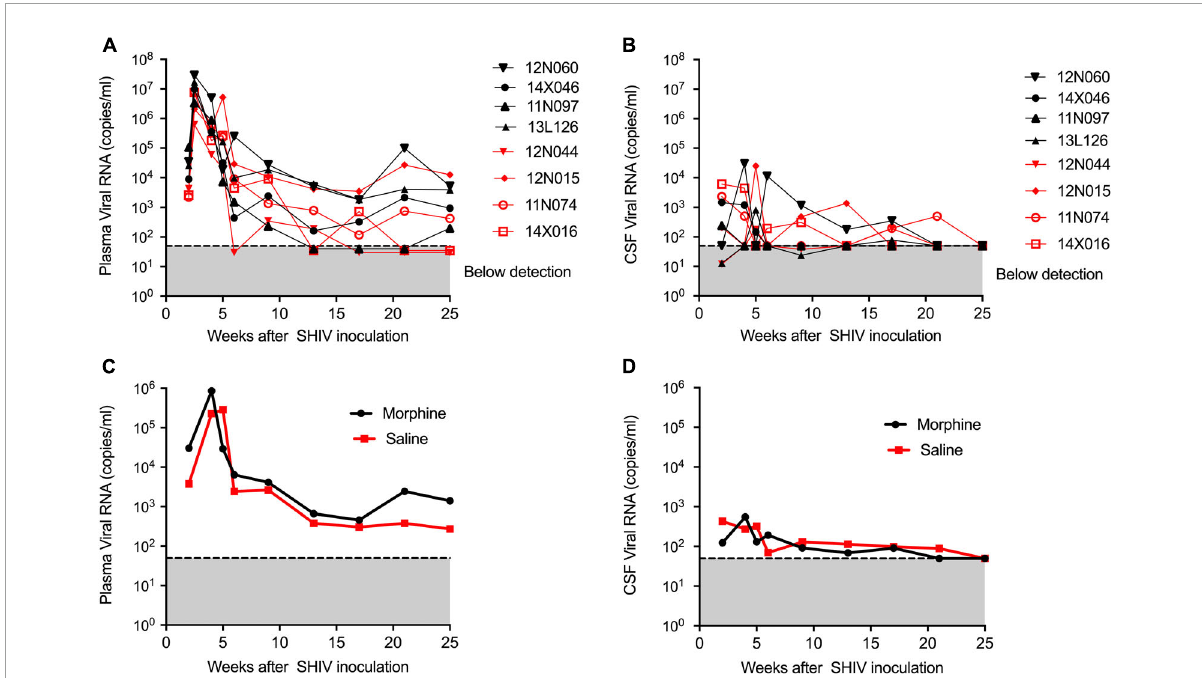
FIGURE1 Kinetics of Plasma and CSF viral loads of morphine administered SHIVADE08 infected rhesus macaques. Plasma and CSF viral loads were quantified using a quantitative PCR (qPCR) assay. Longitudinal viral load measures in (A) plasma and (B) CSF of individual animals exposed to either morphine (red tagged) or saline (blue tagged). Geometric means of (C) plasma viral loads and (D) CSF viral loads were shown. The gray shaded zone displays the limit of detection of the assay (50 copies/ml). No statistical differences were observed between morphine vs. saline exposed SHIV infected rhesus macaques based on Mann–Whitney U -test comparisons at 0, 4, 8, 12, 16, 20, and 24-week timepoints.